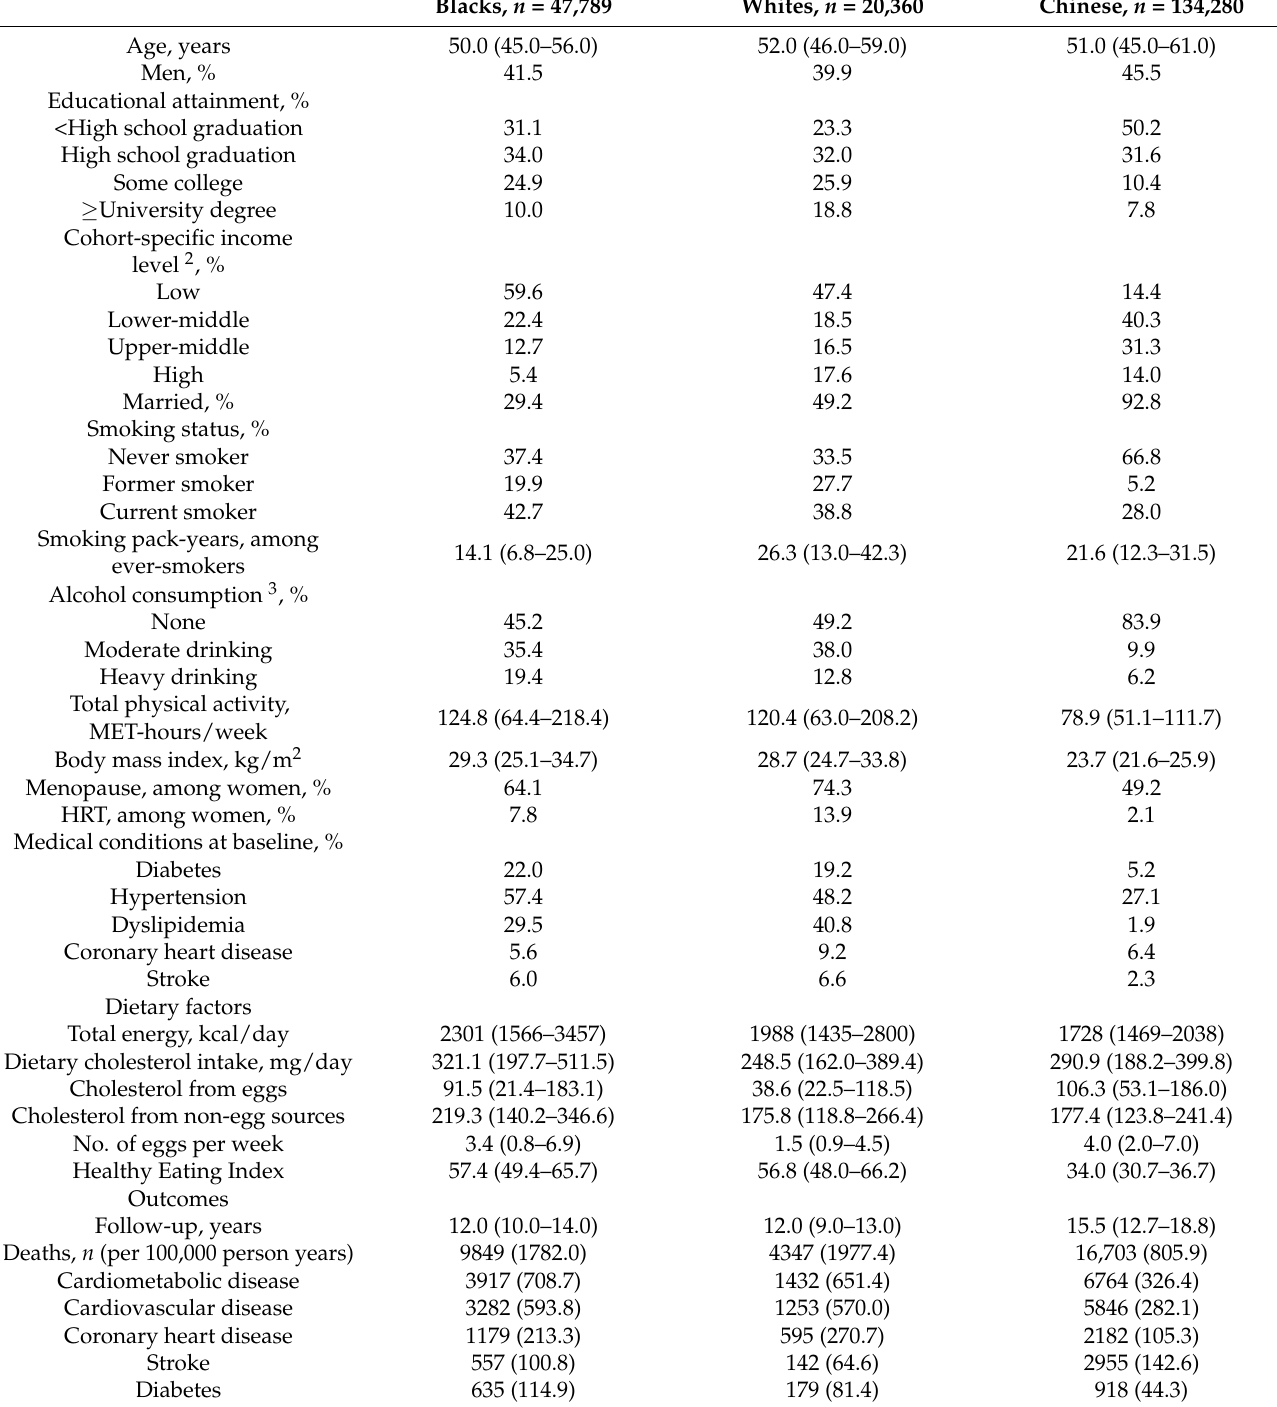
Table 1. Characteristics of study participants 1